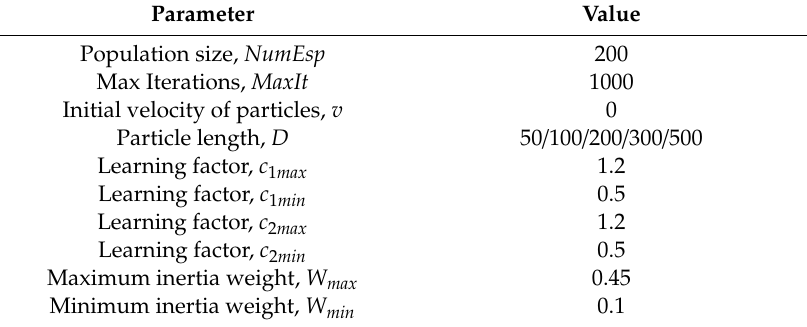
Table 3. Parameters of the specific improvement of the improved particle swarm optimization (SinPSO) and PSO algorithm.